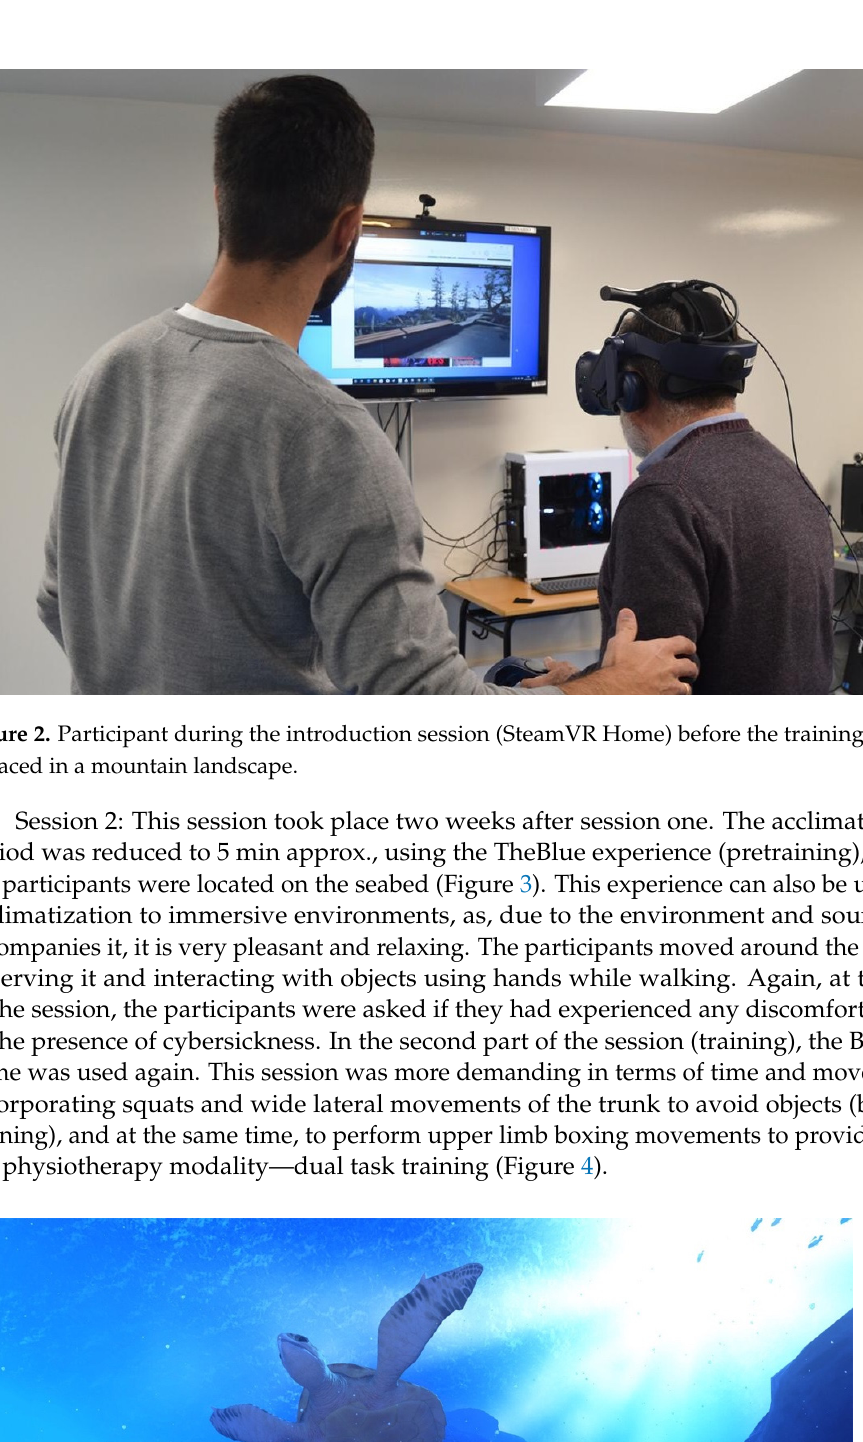
Figure 4. Screenshot of the exergame proposed (BOX VR) for training sessions. Assessments At the end of each session, safety of the immersive experience was evaluated using Simulator Sickness Questionnaire (SSQ) [21], usability of the system was evaluated using System Usability Scale (SUS) [22], and finally, personal experiences were collected using the Game Experience Questionnaire (GEQ-post game module) [23]. In order to reach an understanding about user satisfaction and perceived effort, an ad hoc satisfaction ques- tionnaire was also applied to identify the strengths and weaknesses of the intervention and Borg’s perceived effort scale [24]. These assessment tools have been used in similar research [25–27] and are intended to assess the feasibility of using IVR exercise-based ex- periences. As control measures, during the exergaming task, the average heart rate was monitored by Mi Smart Band 4 wristband and Mi Fit 4.0.14 version app. 3. Results All participants completed the training sessions successfully without any adverse ef- fects in both sessions. Tables 2 and 3 show the results of safety (cybersickness), usability, personal experiences (experience, tiredness and return to reality) and effort scores (per- ceived exertion and heart rate) for each session.